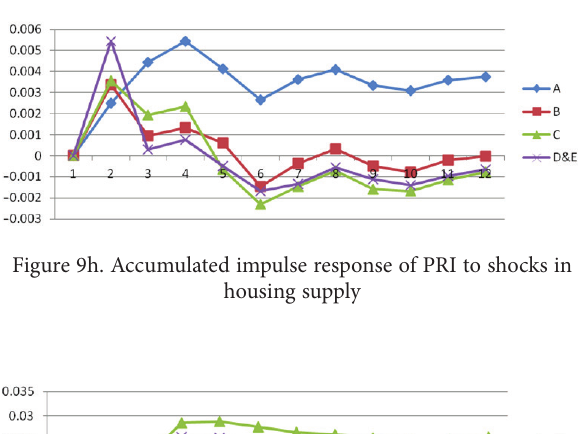
Figure 9g. Accumulated impulse response of PRI to shocks in the number of HOS flats transacted